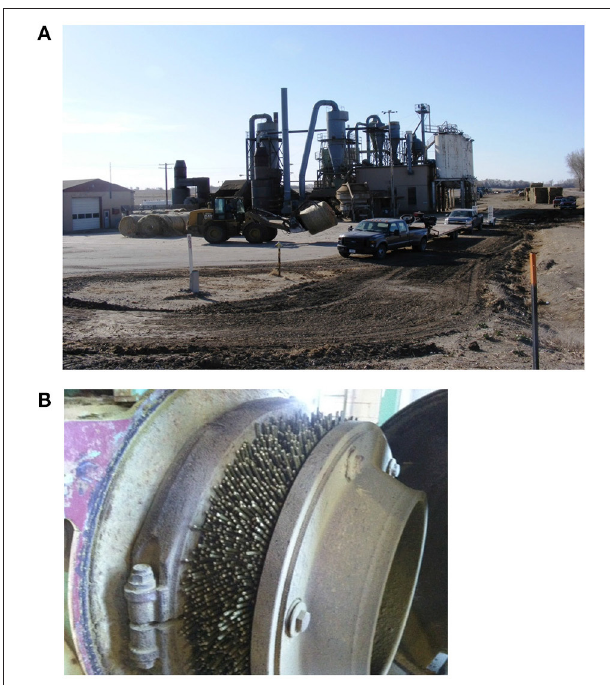
FIGURE 1 | (A) Commercial feed plant that pelletized biomass samples (Dehy Alfalfa Mills, Lyons, NE). (B) Industrial pellet mill used for this study. Pellets were formed without the use of a